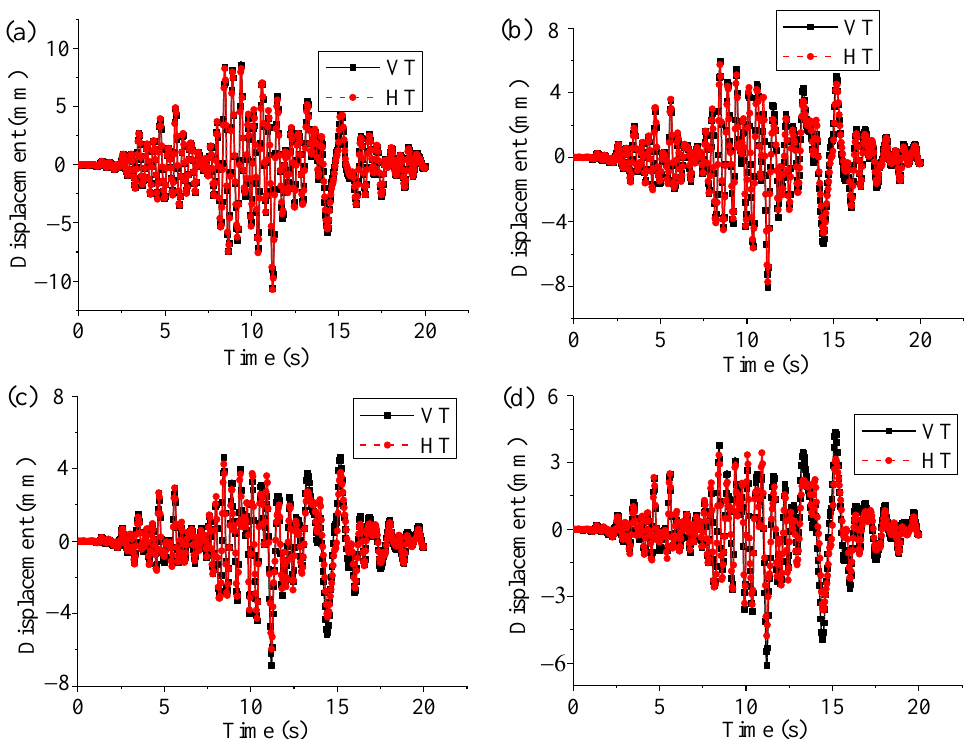
Model B; ( c ) Model C; ( d ) Model D.